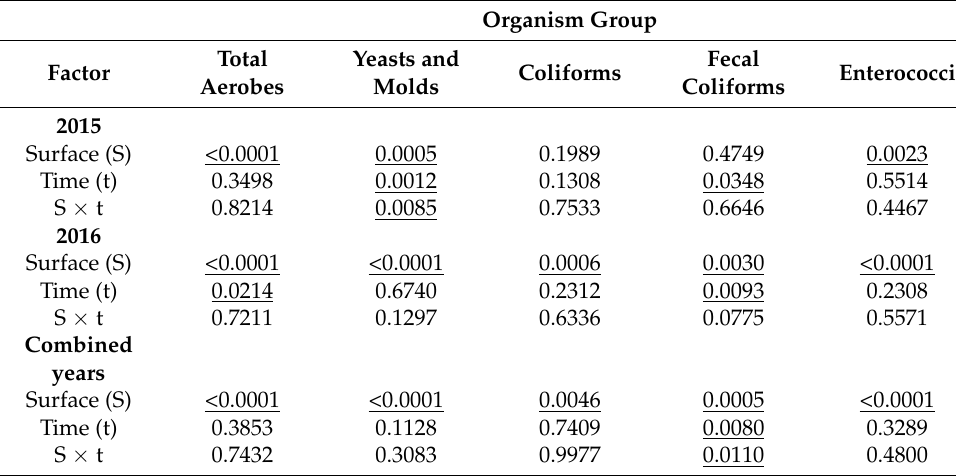
Table 2. p -values of mixed-model analysis of variance for the effects of harvester surface (upper shaking rods, lower shaking rods, upper sidewall, lower sidewall, catcher plates, conveyor belt, and berry lug) and time (AM, noon, PM) on the population density (log 10 ( x + 1) colony-forming units per cm 2 ) of environmental and fecal indicator organisms across seven mechanical blueberry harvesters in each of 2015 and 2016 1 . Organism Group Fecal Total Yeasts and Enterococci Coliforms Factor Coliforms Aerobes Molds 2015 Surface (S) <0.0001 0.0005 0.1989 0.4749 0.0023 Time (t) 0.3498 0.0012 0.1308 0.0348 0.5514 S × t 0.8214 0.0085 0.7533 0.6646 0.4467 2016 Surface (S) <0.0001 <0.0001 0.0006 0.0030 <0.0001 Time (t) 0.0214 0.6740 0.2312 0.0093 0.2308 S × t 0.7211 0.1297 0.6336 0.0775 0.5571 Combined years Surface (S) <0.0001 <0.0001 0.0046 0.0005 <0.0001 Time (t) 0.3853 0.1128 0.7409 0.3289 S × t 0.7432 0.3083 0.9977 0.0110